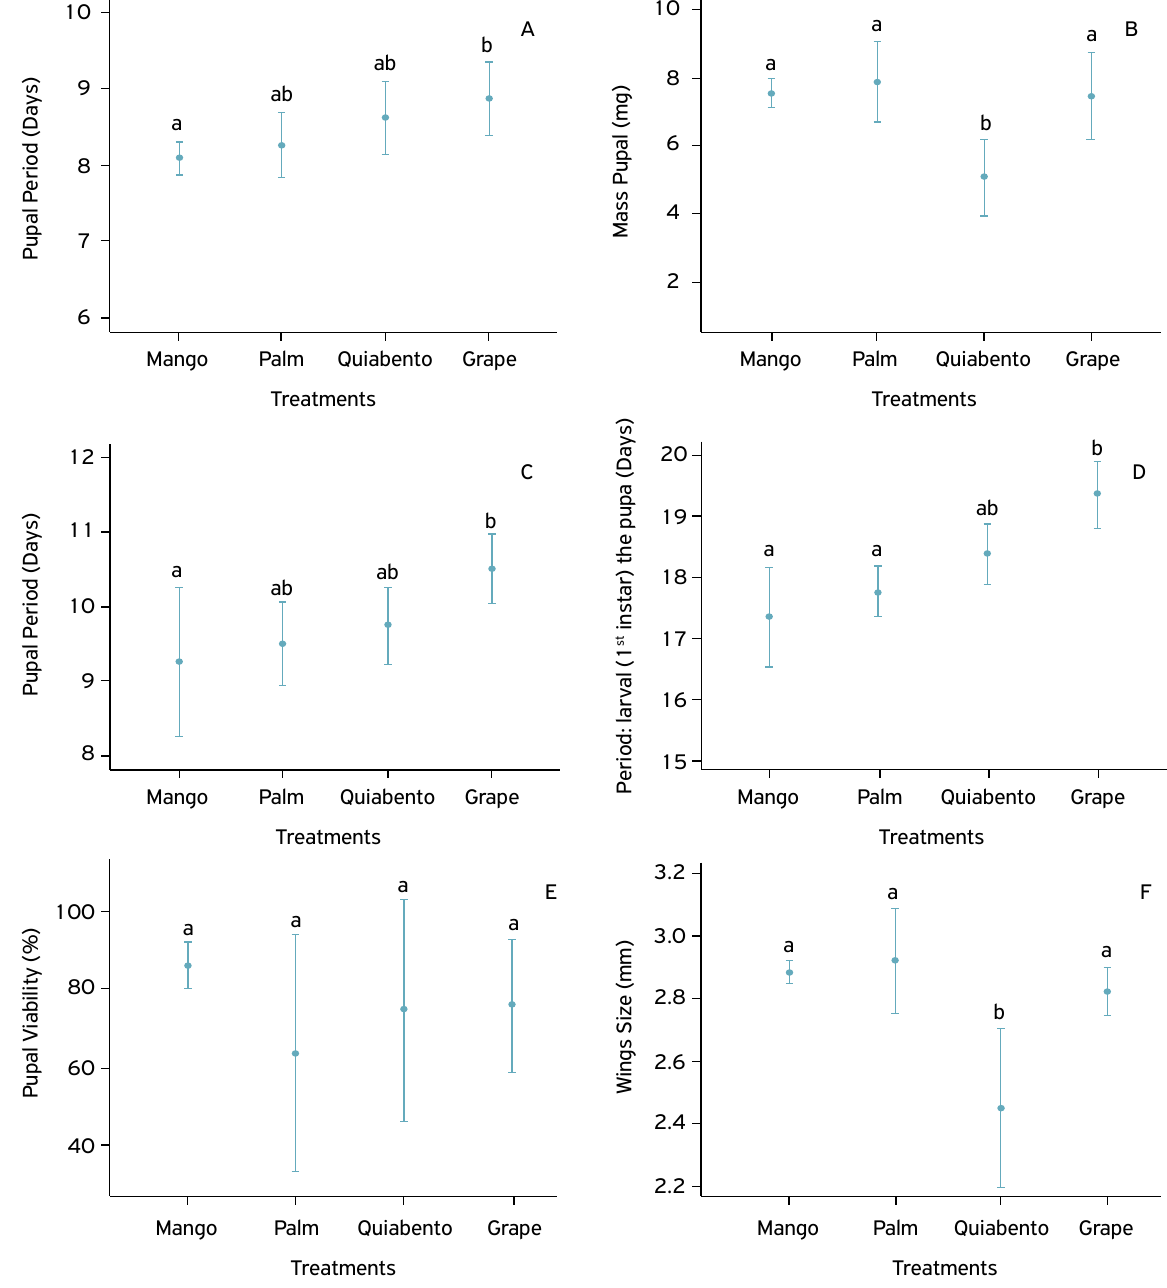
Figure 3. Larval period of 1 st instar C. capitata (A), Mass pupal (B), Pupal Period (C), Period total of development (D), Pupal viability (E) e Wing size (F) of C. capitata created in four types of fruit. Means followed by equal letters do not differ by Tukey test (p<0.05). Vitória da Conquista, BA,